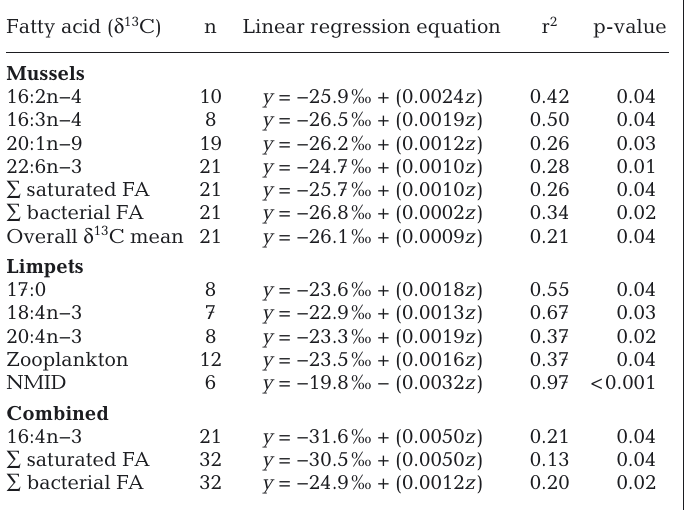
Table 1. Linear regression results from significant relationships (p < 0.05) among δ 13 C of fatty acids (FA) in mussels and limpets and distance ( z) away from aquaculture sites near Vancouver Island. ‘Overall δ 13 C mean’ is the mean δ 13 C of all identified FA weighted by FA concentration;